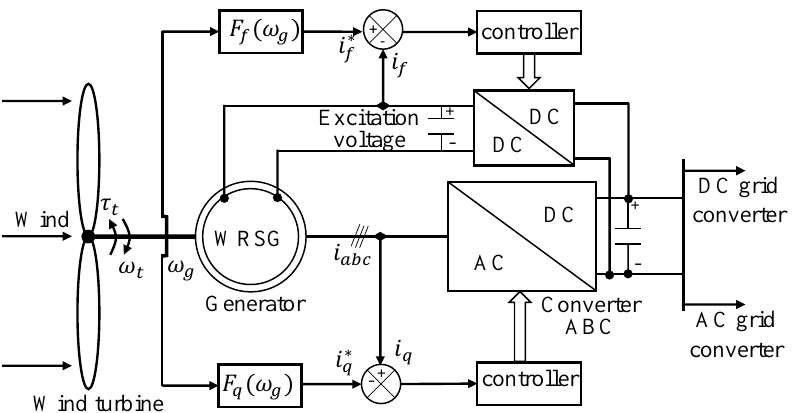
Figure 1. Block diagram of the variable-speed WRSG-based direct-drive wind turbine